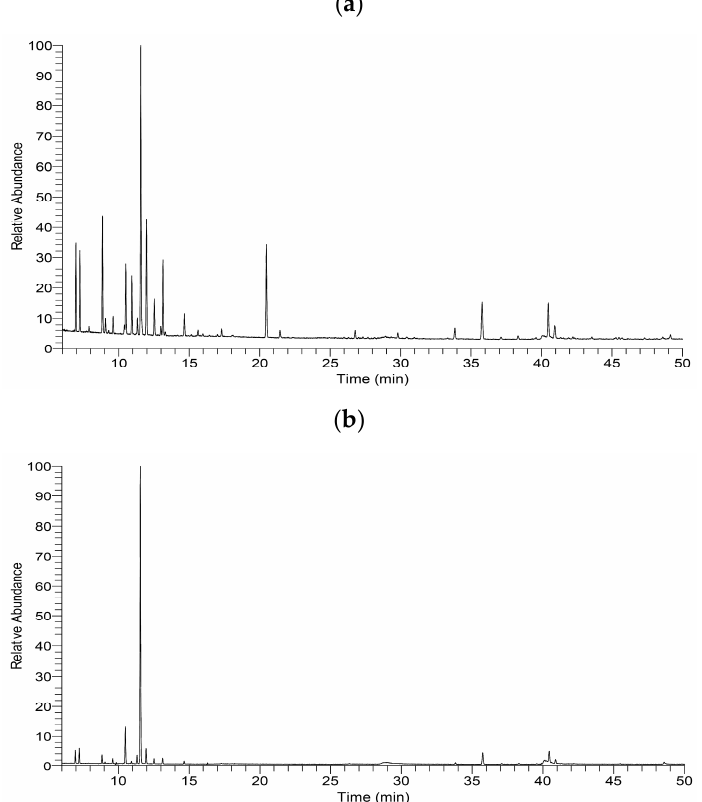
Figure 2. Gas chromatograms of Pistacia chinensis leaf essential oil and fraction E1. ( a ) Leaf essential oil; ( b ) fraction E1.